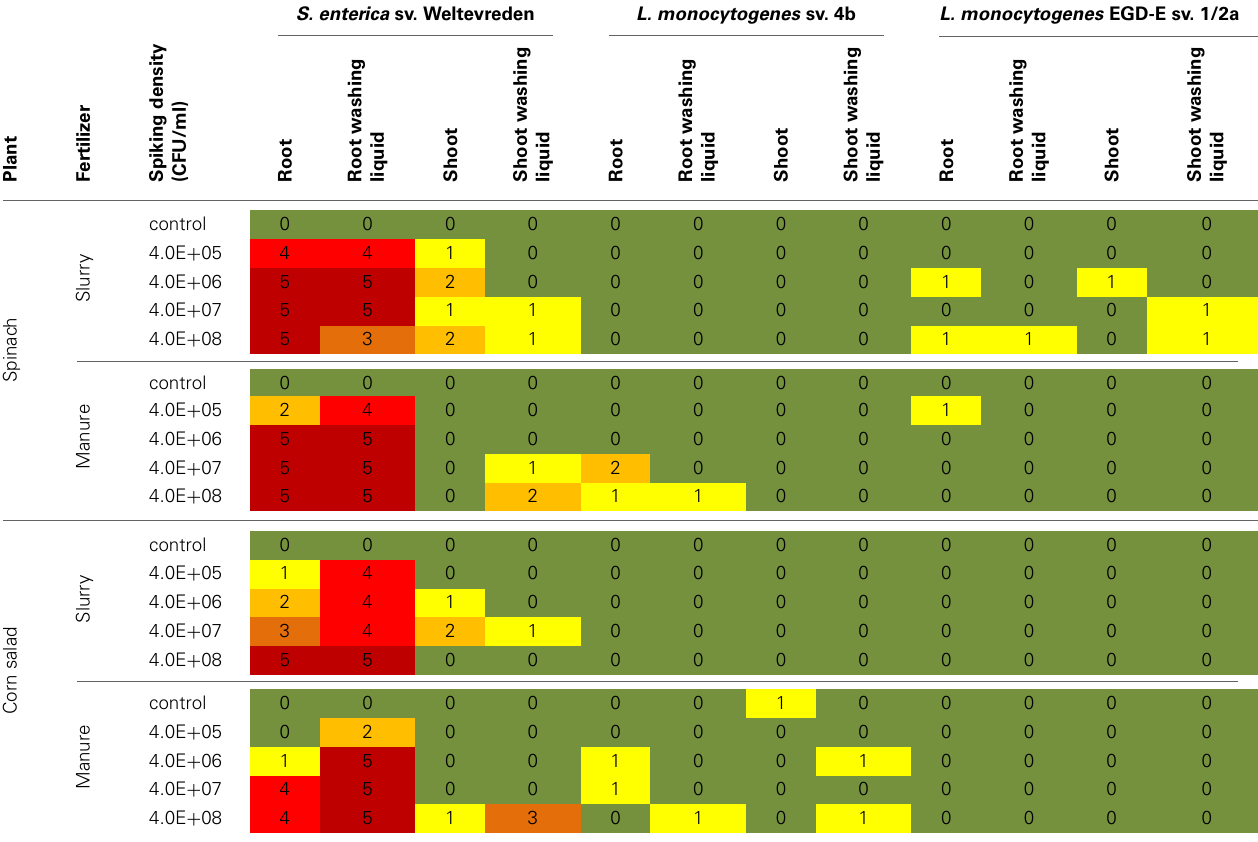
Table 2 | Results of the spiking experiments in the soil